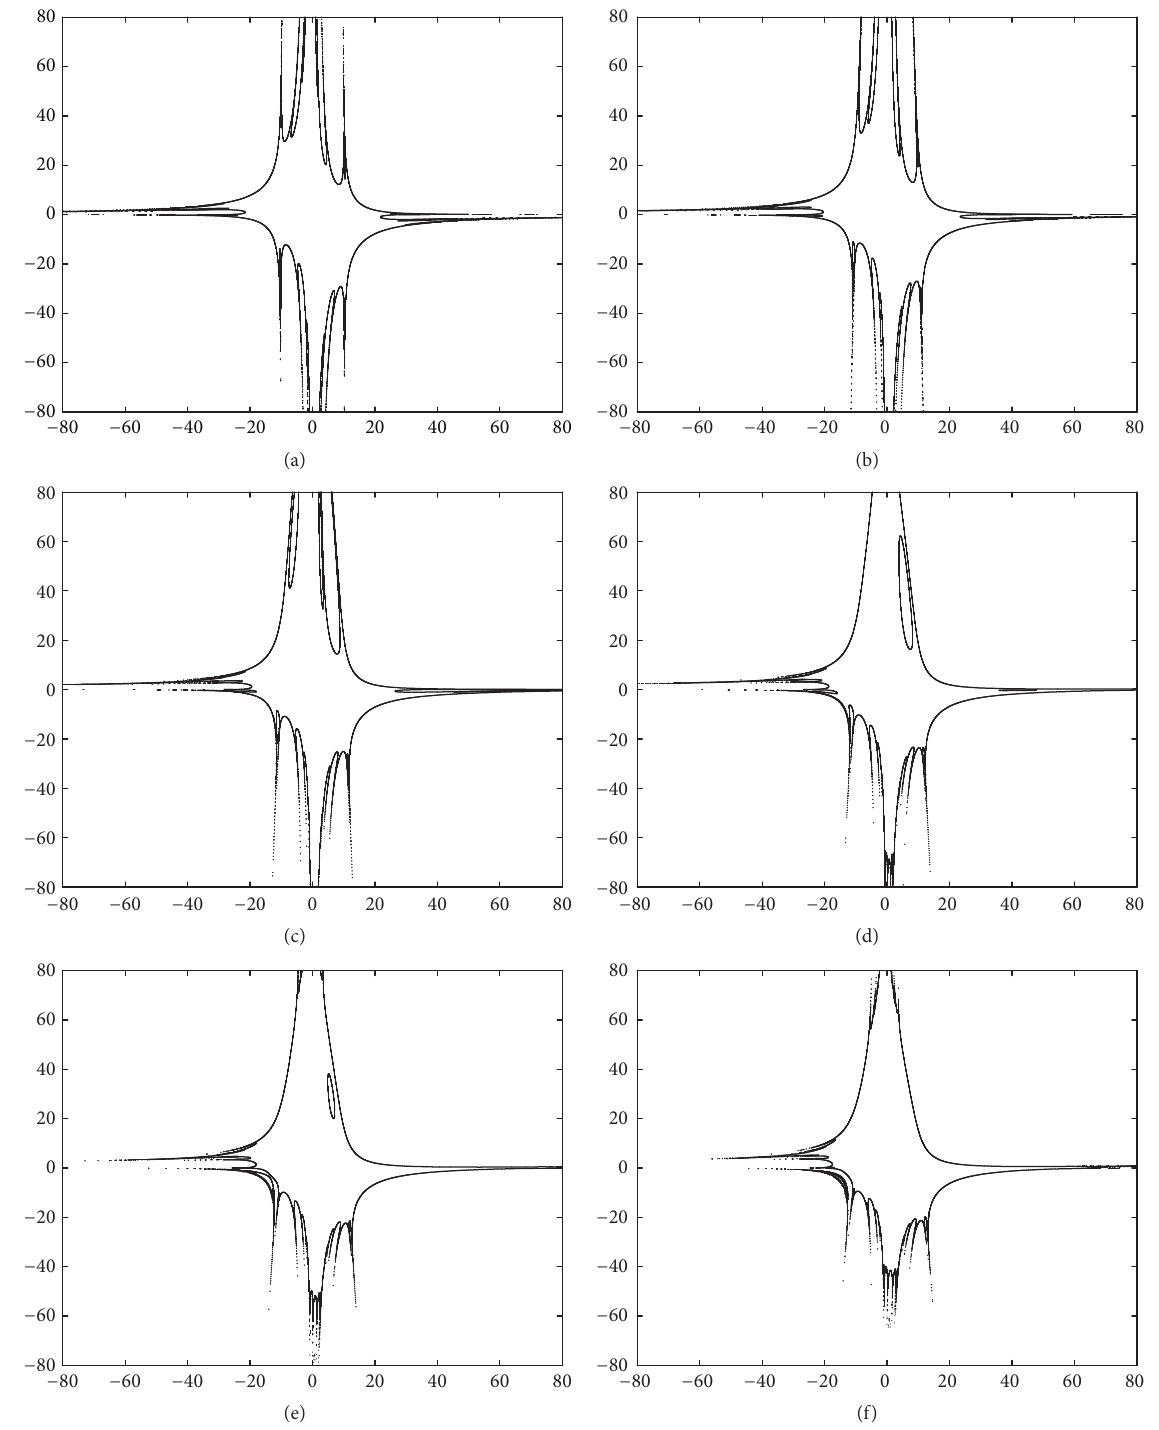
Figure 8: The change of the Julia sets of the controlled system when 𝑎 = 0.07, 𝑏 = 0.02 , and 𝛾 = 0.01 . (a) 𝑘 = −0.0005 ; (b) 𝑘 = −0.004 ; (c) 𝑘 = −0.008 ; (d) 𝑘 = −0.012 ; (e) 𝑘 = −0.016 ; (f) 𝑘 = −0.020